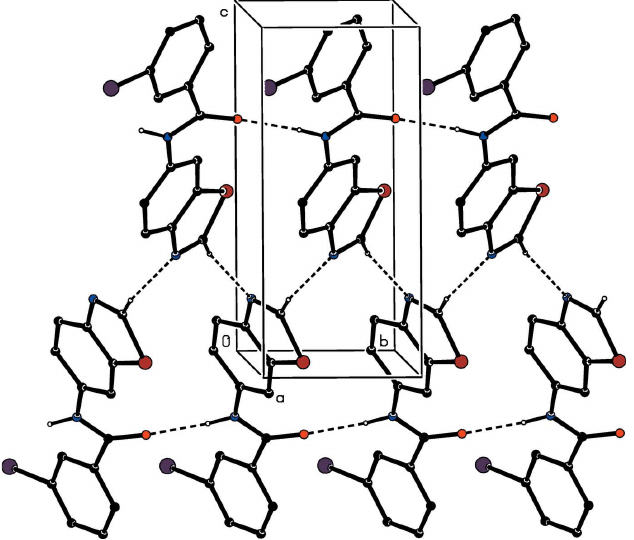
Figure 4 Part of the crystal structure of (I) showing the formation of a ribbon of R 3 (19) rings running parallel to [010] and built from N—H (cid:3)(cid:3)(cid:3) O and C— 3 H (cid:3)(cid:3)(cid:3) N hydrogen bonds. Hydrogen bonds are drawn as dashed lines and, for the sake of clarity, the H atoms not involved in the motifs shown have been omitted.